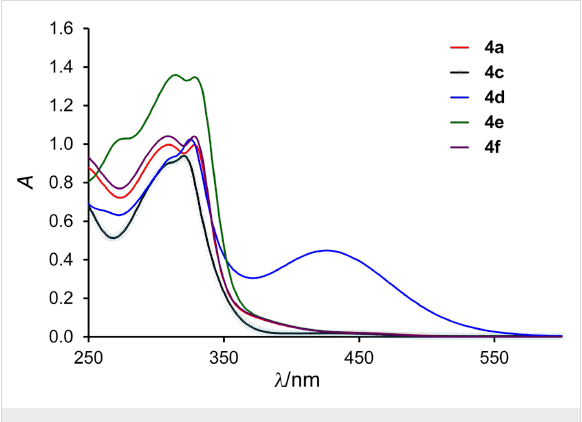
Figure 3: UV–vis spectra of compounds 4a,c–f (CH 2 Cl 2 , c = 4 × 10 − 5